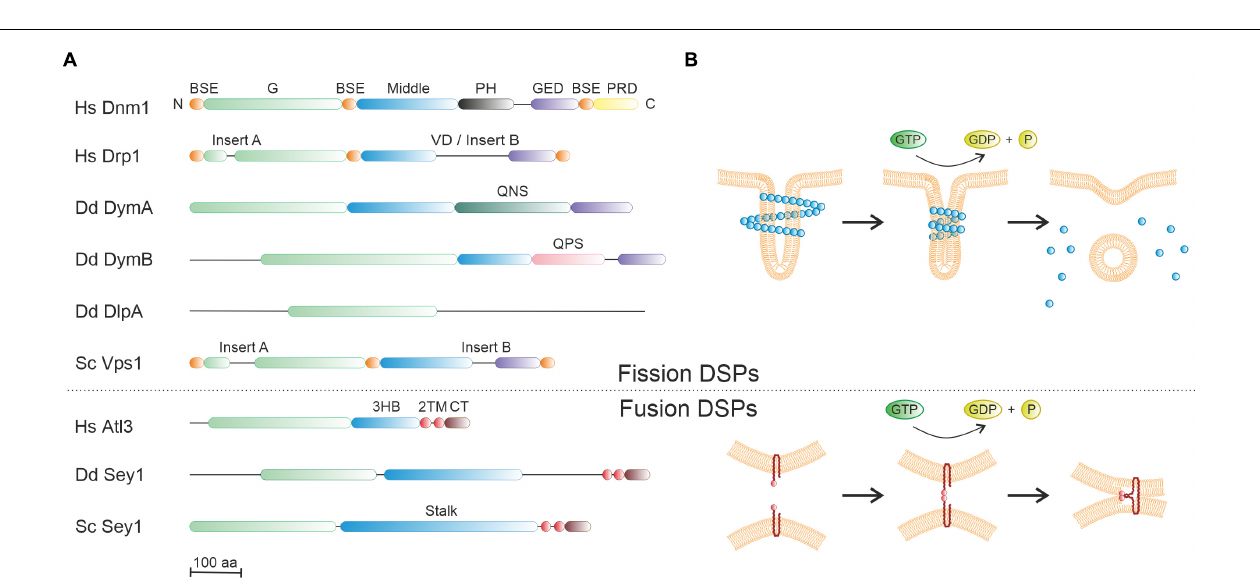
FIGURE 2 | Phylogenetic tree of eukaryotic dynamin superfamily proteins. Evolutionary analyses were conducted using the MUSCLE algorithm for sequence alignment in the Molecular Evolutionary Genetics Analysis (MEGA) X software package (Kumar et al., 2018); the phylogenetic tree was built using the Maximum Likelihood method and Le-Gascuel model (Le and Gascuel, 2008). The tree is drawn to scale, with branch lengths corresponding to the number of substitutions per site. Numbers on the branches indicate bootstrap support for nodes from 500 bootstrap replicates (only values above 75% are shown). The scale bar represents the estimated evolutionary distance (number of amino acid substitutions per site).